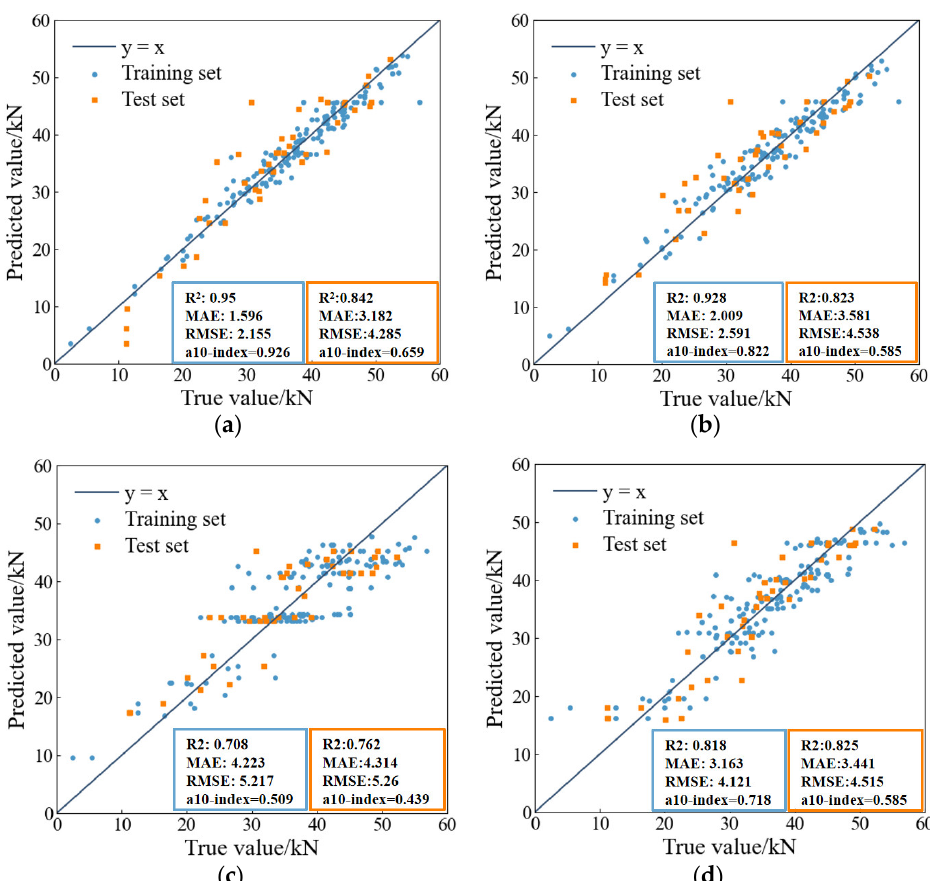
Figure 9. Comparison of the ML models. ( a ) XGBoost. ( b ) RF. ( c ) AdaBoost. ( d ) LightGBM.